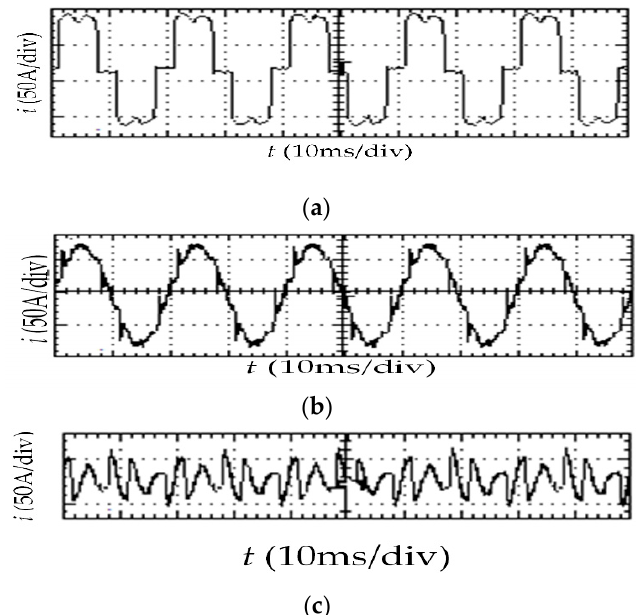
Figure 9. Waveforms of load, source and harmonic current. ( a ) Three-phase uncontrolled rectifier load current waveform; ( b ) Source current waveform after APF compensation; ( c ) Harmonic current waveform.